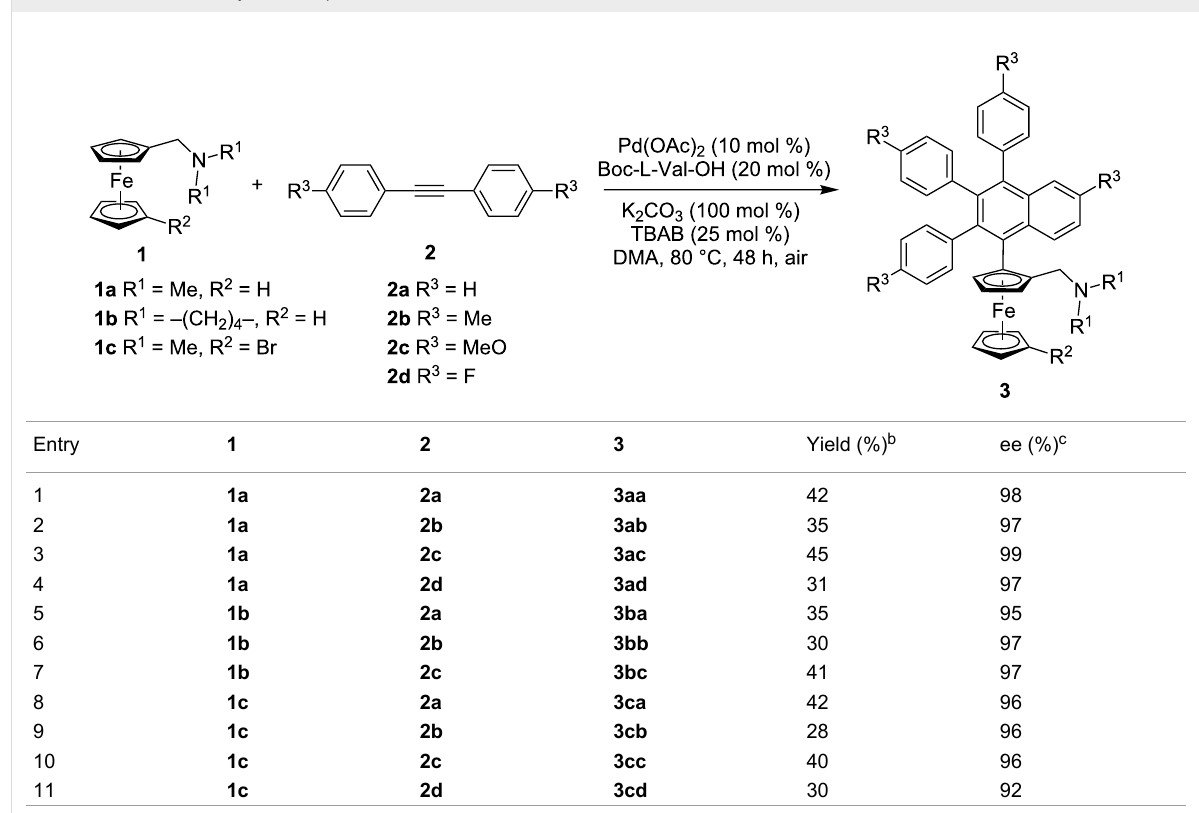
Table 2: Enantioselective synthesis of planar chiral ferrocenes via C–H activation a .